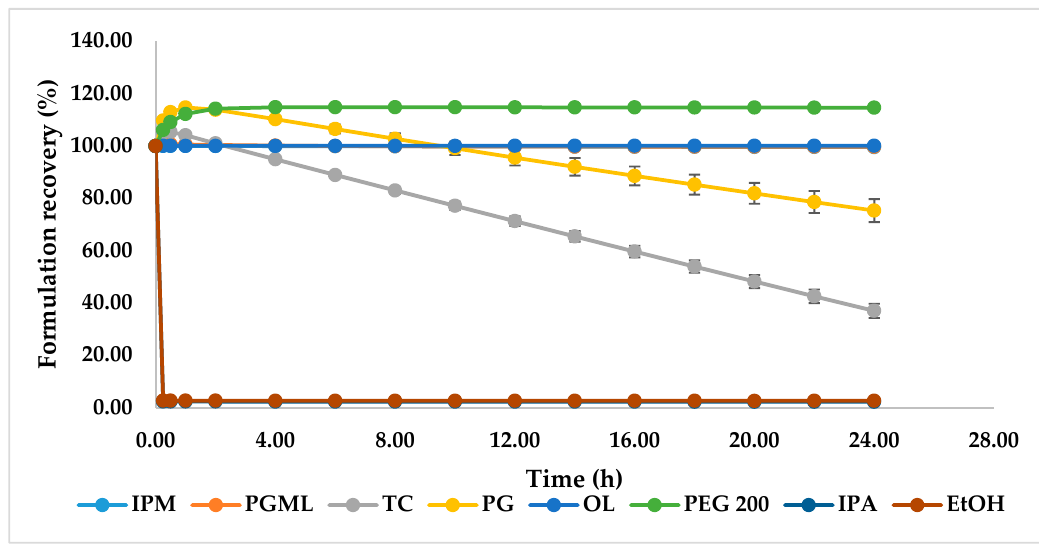
Pharmaceutics 2019 , 11 , x Figure 5. Percentage weight change for 1% ( w / w ) TBF-free base formulations in IPM, PGML, TC, PG, OL, PEG 200, EtOH, and IPA at 32 ± 1 ◦ C and 50 ± 1% RH ( n = 3, mean ± SD). 3.5. In Vitro Finite Dose Neat Solvent and Commercial Formulation Efficacy in Porcine Skin